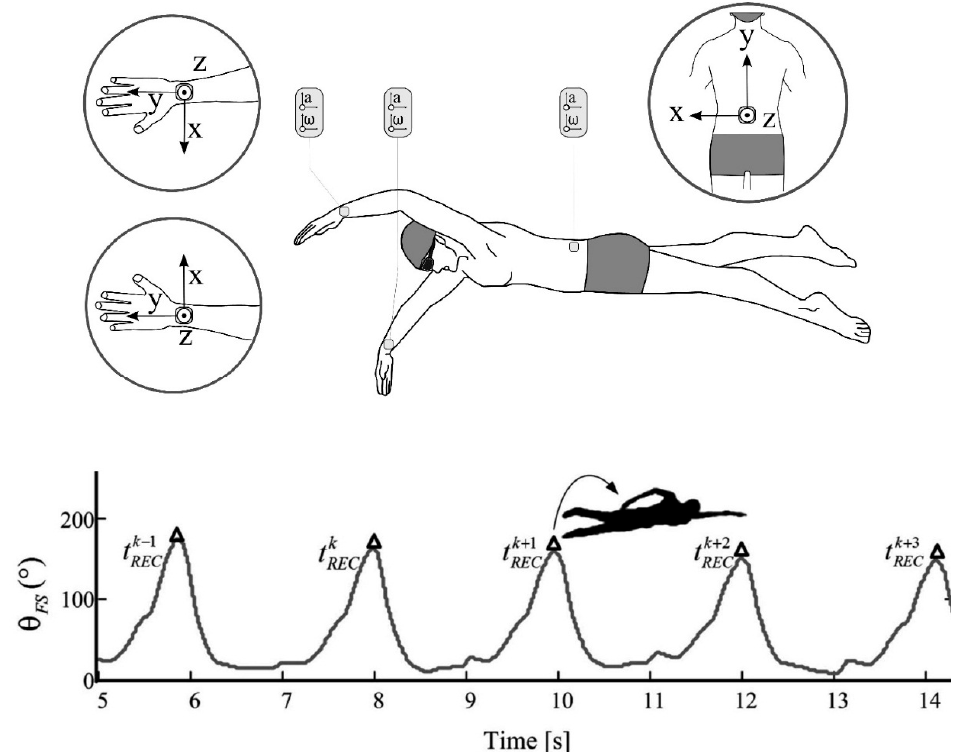
Figure 8. The changing angle between the Y-axis of sensors worn at the sacrum and on the forearm, measured using the gyroscopic signal and used to determine the start of the recovery phase, which occurs when the angle is at a maximum value. Reproduced with permissions from Dadashi, Crettenand, Millet, Seifert, Komar and Aminian [10].